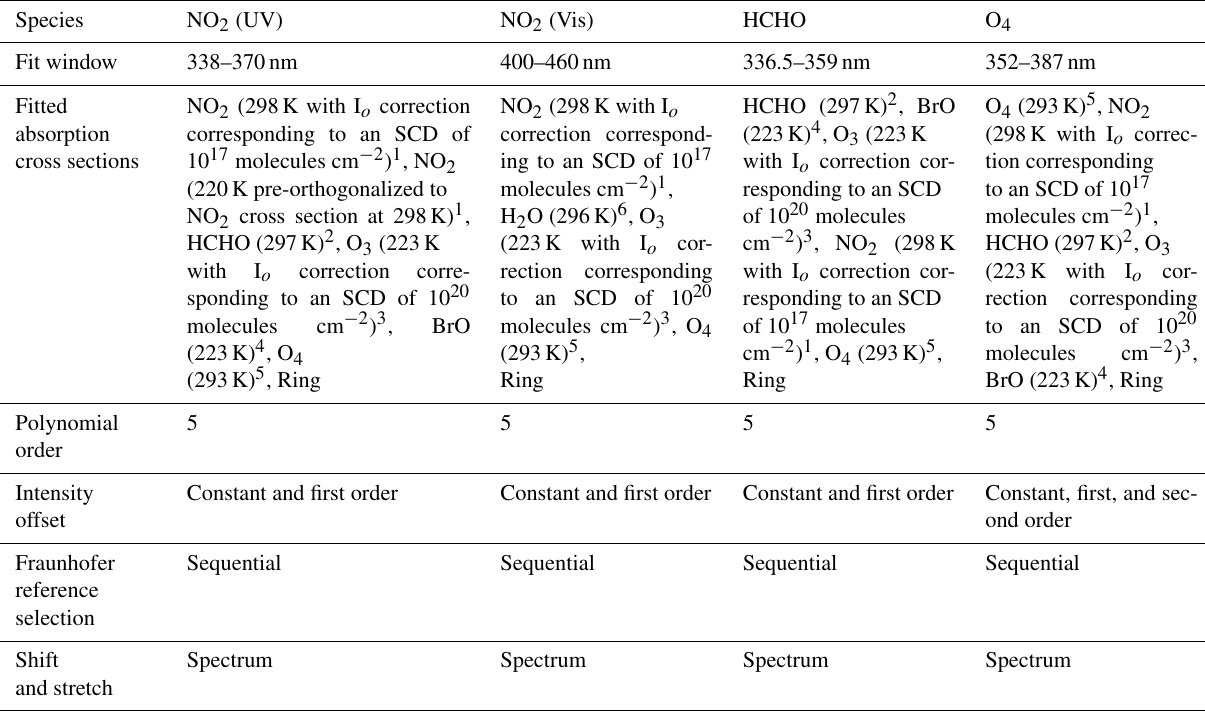
Table 1. Spectral analysis settings and considered cross sections in QDOAS for the retrieval of dSCDs of NO 2 (in UV and Vis), HCHO, and O 4 .